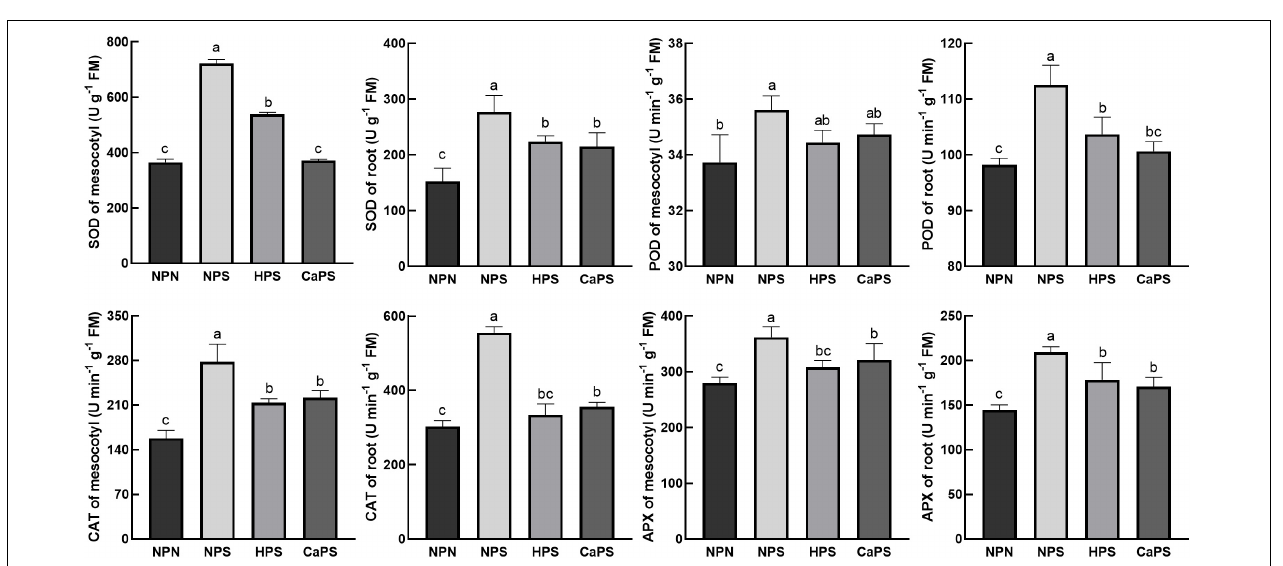
FIGURE 7 | Effect of CaCl 2 priming on antioxidant enzyme activities in sorghum tissue under salt stress.